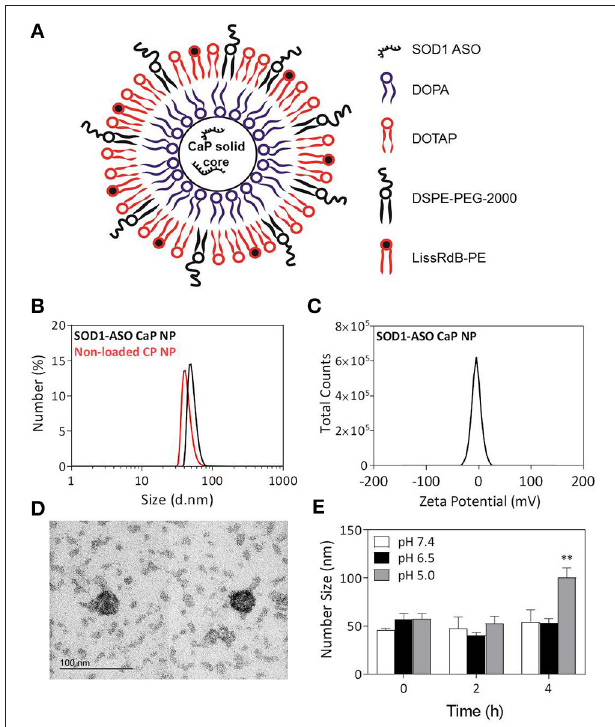
FIGURE 1 | Physical properties of SOD1-ASO-loaded CaP-lipid NPs with a Ca/P ratio 100:1. Schematic representation of SOD1-ASO loaded CaP-lipid NP formulation (A) , particle size (d.nm) of SOD1-ASO loaded (black) and non-loaded (red) CaP-lipid NPs determined by DLS (B) , zeta potential of SOD1-ASO CaP-lipid NP (C) , transmission electron micrograph (TEM) of SOD1-ASO CaP-lipid NPs visualized by negative staining (D) , pH-sensitivity as indicated by change in number size (d.nm) of CaP-lipid NPs in PBS at pH 7.4, 6.5, and 5.0 following incubation at 37 ◦ C for up to 4 h (E) . ** P < 0.01.